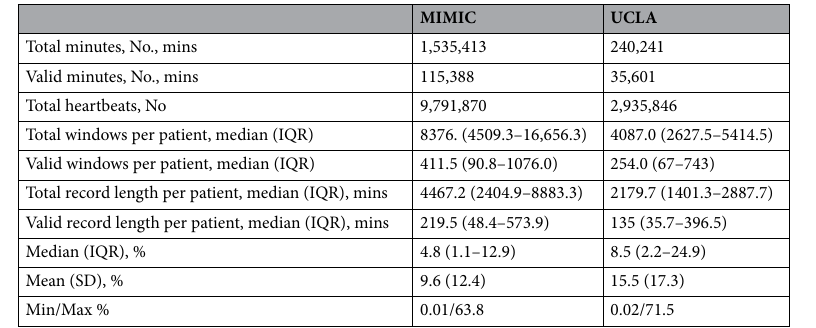
Table 5. Window filtering statistics for each